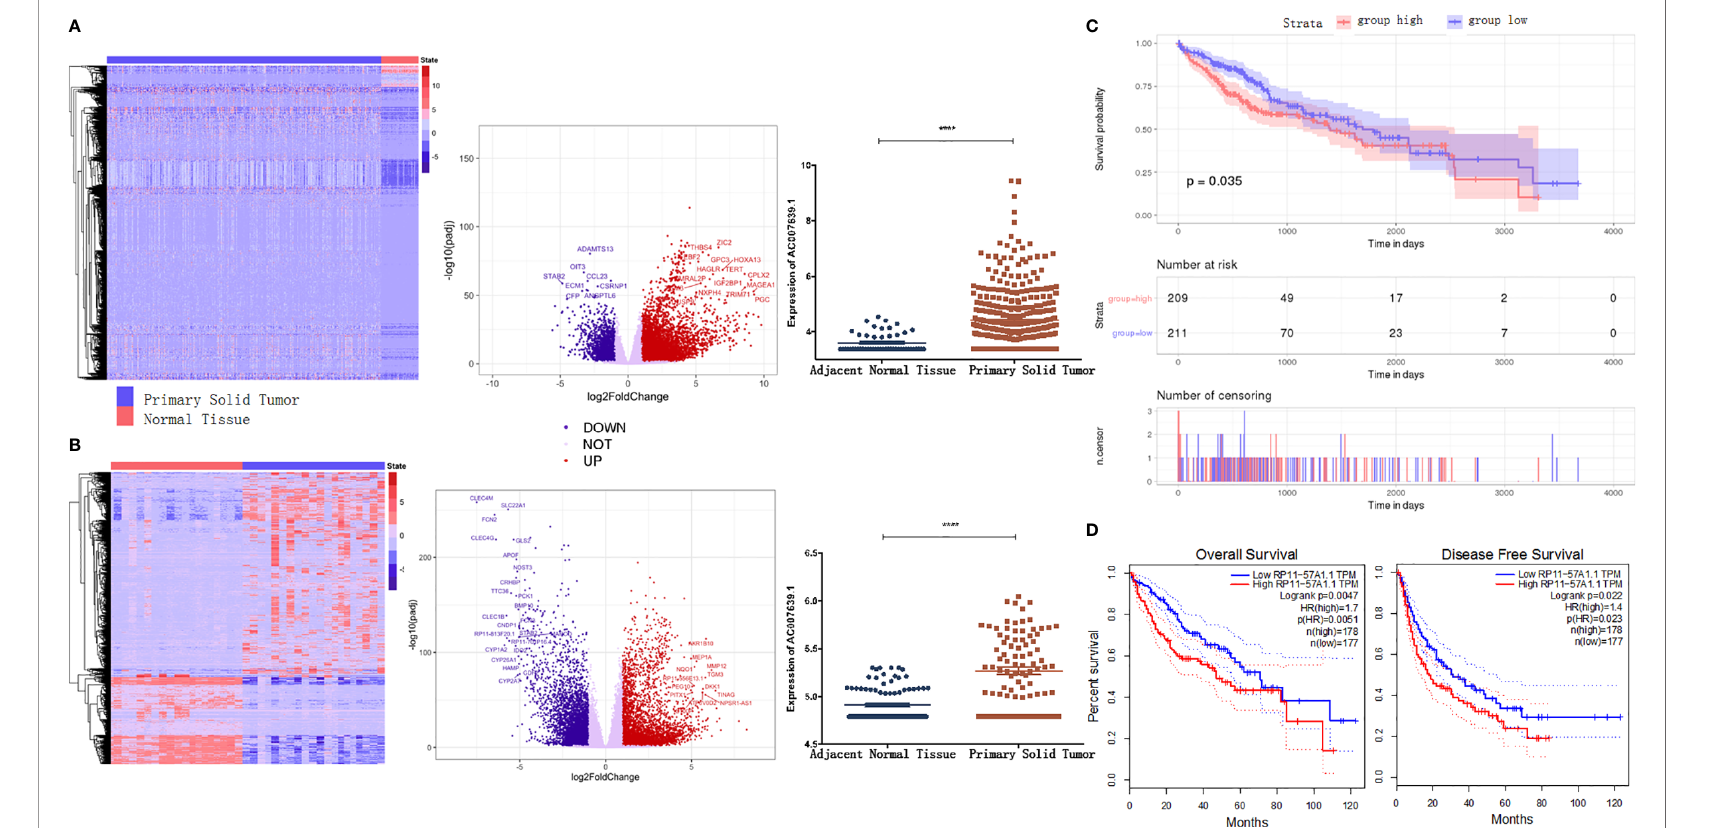
FIGURE 1 | LncRNA AC007639.1 is highly expressed in hepatocellular carcinoma tissues and implies a poor prognosis. (A) Heatmap of transcriptome (left) and volcano plot (middle) of different genes, and lncRNA AC007639.1 expressions in TCGA-LIHC cases (right, n=420, https://gdc.cancer.gov/resources-tcga-users/tcga-code-tables/data-levels); (B) Heatmap of transcriptome (left) and volcano plot (middle) of different genes, and lncRNA AC007639.1 expressions in SRP069212 cases (right, n=355); (C, D) Kaplan-Meier survival curves of TCGA-LIHC dataset analyzed by TCGAbiolinks or SRP069212 dataset analyzed by GEPIA, respectively. ****p < 0.001 (Mann-Whitney